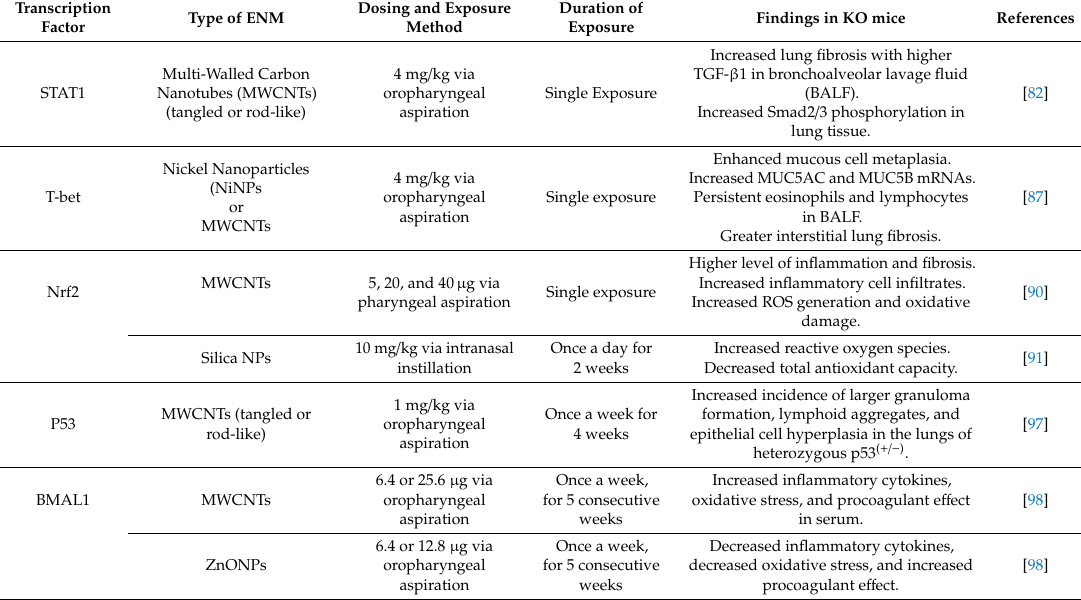
Table 1. Summarized list of transcription factors that may be involved in the susceptibility to ENM-induced chronic lung